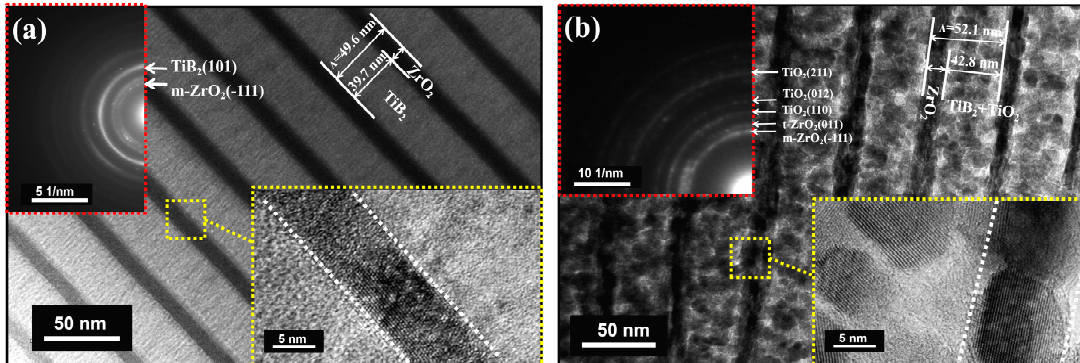
Figure 3. Cross-sectional HRTEM images and the corresponding SAED patterns of TiB 2 / ZrO 2 ( t TiB = 4:1) multilayers before ( a ) and after annealing at 600 ◦ C for 1 h ( b ).